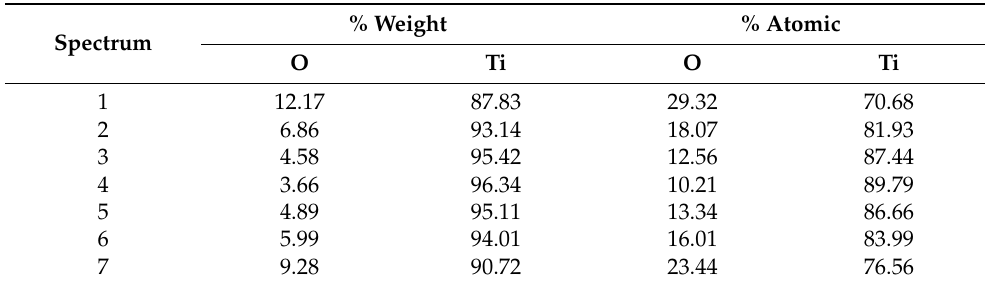
Table 3. Chemical composition estimated via the EDS spectra of TiO x arc-PVD coatings deposited using 300/100 Ar/O 2 flow ratio.